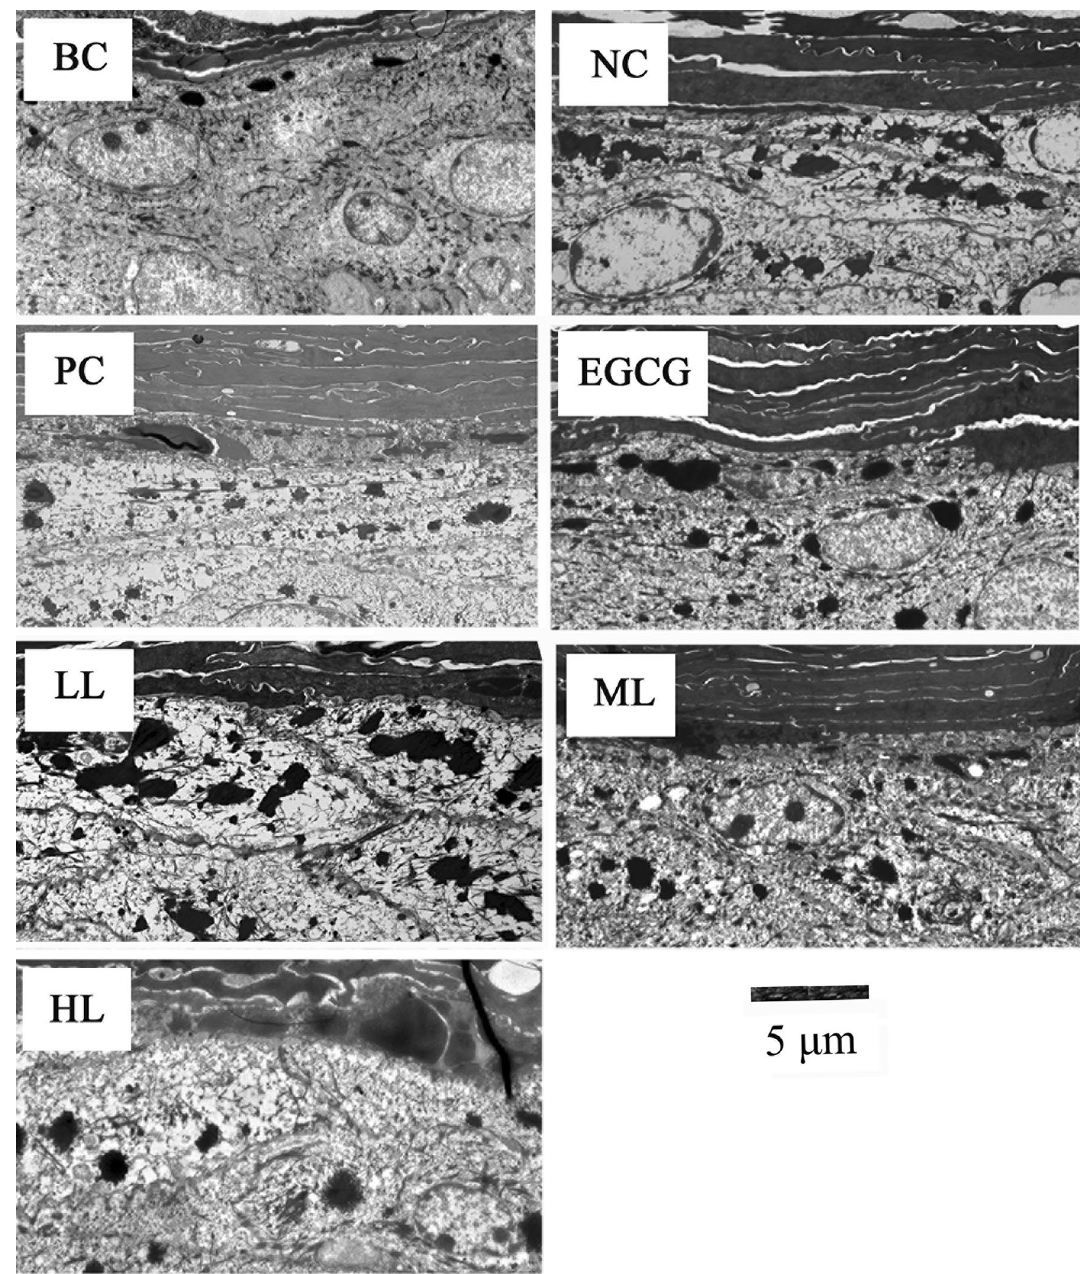
Figure 3. Effects of GCG on UVB-induced melanosome formation in male hairless mice skin. BC blank control, NC negative control, PC positive control, EGCG EGCG treatment, LL low level GCG treatment, ML